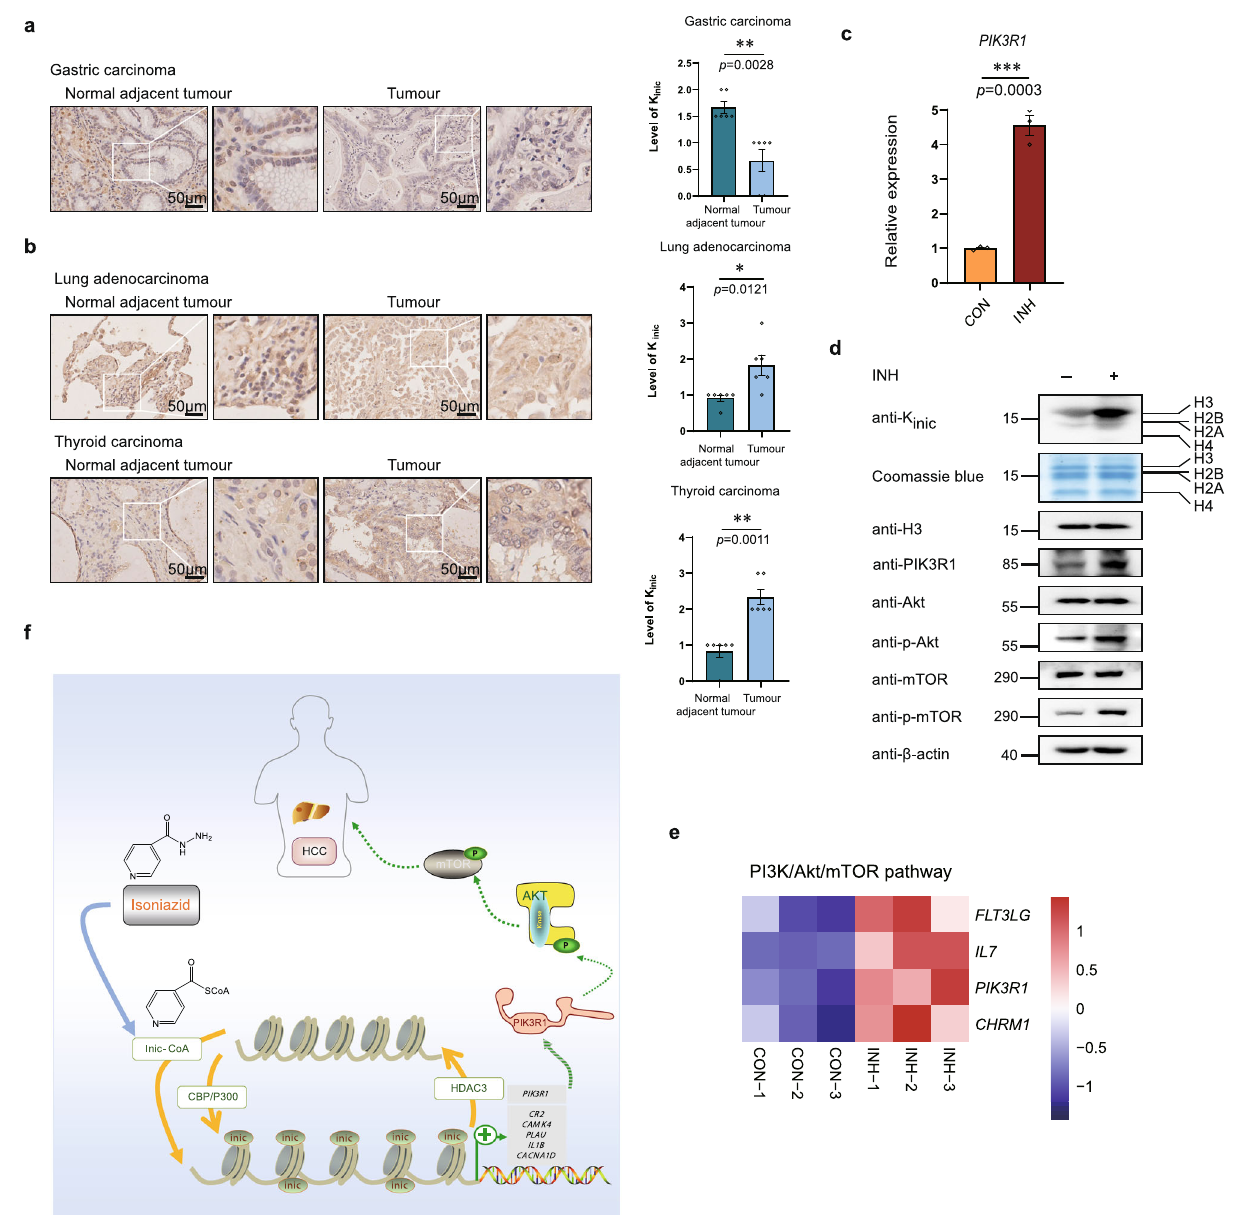
Fig. 6 INH-induced histone isonicotinylation varies in tumours and upregulated cancer-related signalling pathway. a , b Detection of K inic mark in normal adjacent tumour tissues and tumour tissues. a Normal adjacent tumour tissue and tumour tissue of gastric carcinoma were performed by immunohistochemical staining with pan-K inic antibody, followed by visualization with light microscopy. Scale bar, 50 μ m (left). Quanti fi cations of the scores of immunohistochemical staining (right) ( n = 6 samples, values were expressed as mean ± SEM, as determined by paired two-tailed Student ’ s t- test). b Normal adjacent tumour tissues and tumour tissues of lung adenocarcinoma and thyroid carcinoma were performed by immunohistochemical staining with pan-K inic antibody respectively, followed by visualization with light microscopy. Scale bar, 50 μ m. Quanti fi cations of the scores of immunohistochemical staining (right) ( n = 6 samples, values were expressed as mean ± SEM, as determined by paired two-tailed Student ’ s t- test). c Relative mRNA expression of PIK3R1 in HepG2 cells treated with or without 10 mM INH for 12 h and determined by real-time RT-PCR assay. Relative expression is normalized to GAPDH, “ CON ” indicates untreated HepG2 cells; “ INH ” indicates isoniazid treated HepG2 cells, data presented are the mean ± SEM from three biological replicates ( n = 3), as determined by unpaired two-tailed Student ’ s t- test. d HepG2 cells were treated with or without 10 mM INH for 18 h, core histones acid-extracted and tested using pan-K inic , and H3 antibodies. Total histones were visualized with Coomassie blue staining. And total proteins were extracted and tested using PIK3R1, Akt, p-Akt, mTOR, p-mTOR, and β -actin antibodies by Western blot analysis. e Heatmap displaying differentially expressed genes involved in PI3K/Akt/mTOR pathway in response to INH in RNA-seq data. “ CON ” indicates untreated HepG2 cells; “ INH ” indicates isoniazid treated HepG2 cells; p < 0.05, log FC > 1. f A graphical model o f histone isonicotinylation.